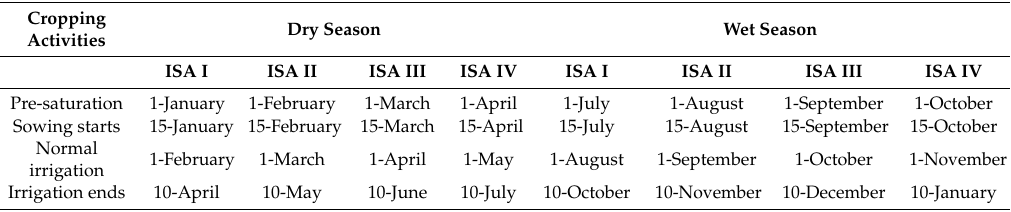
Table 1. Current cropping calendar and distribution of irrigation supplies for the dry and wet irrigation seasons in the Tanjung Karang Rice Irrigation